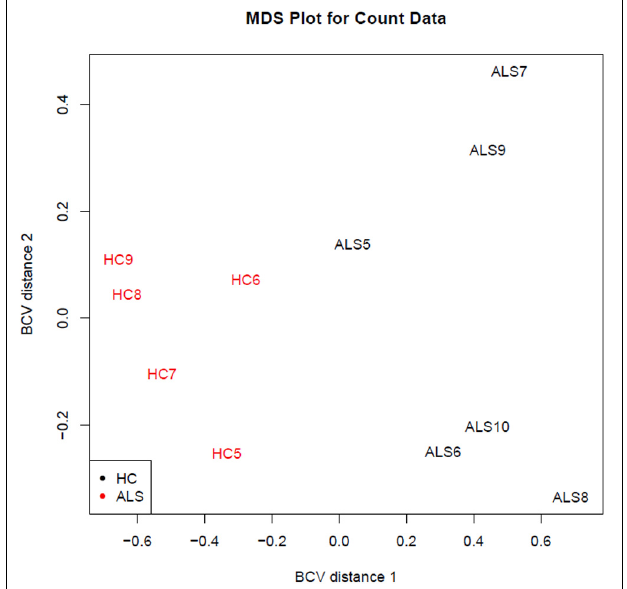
FIGURE 7 | Distribution of the study samples by sRNA-seq output (discovery phase). The sRNA-Seq data were explored by generating multi-dimensional scaling (MDS) plots. This visualizes the differences between the expression profiles of different samples in two dimensions using the biological coefficient of variation (BCV). The MDS plot shows clear separation of the sALS vs. HC